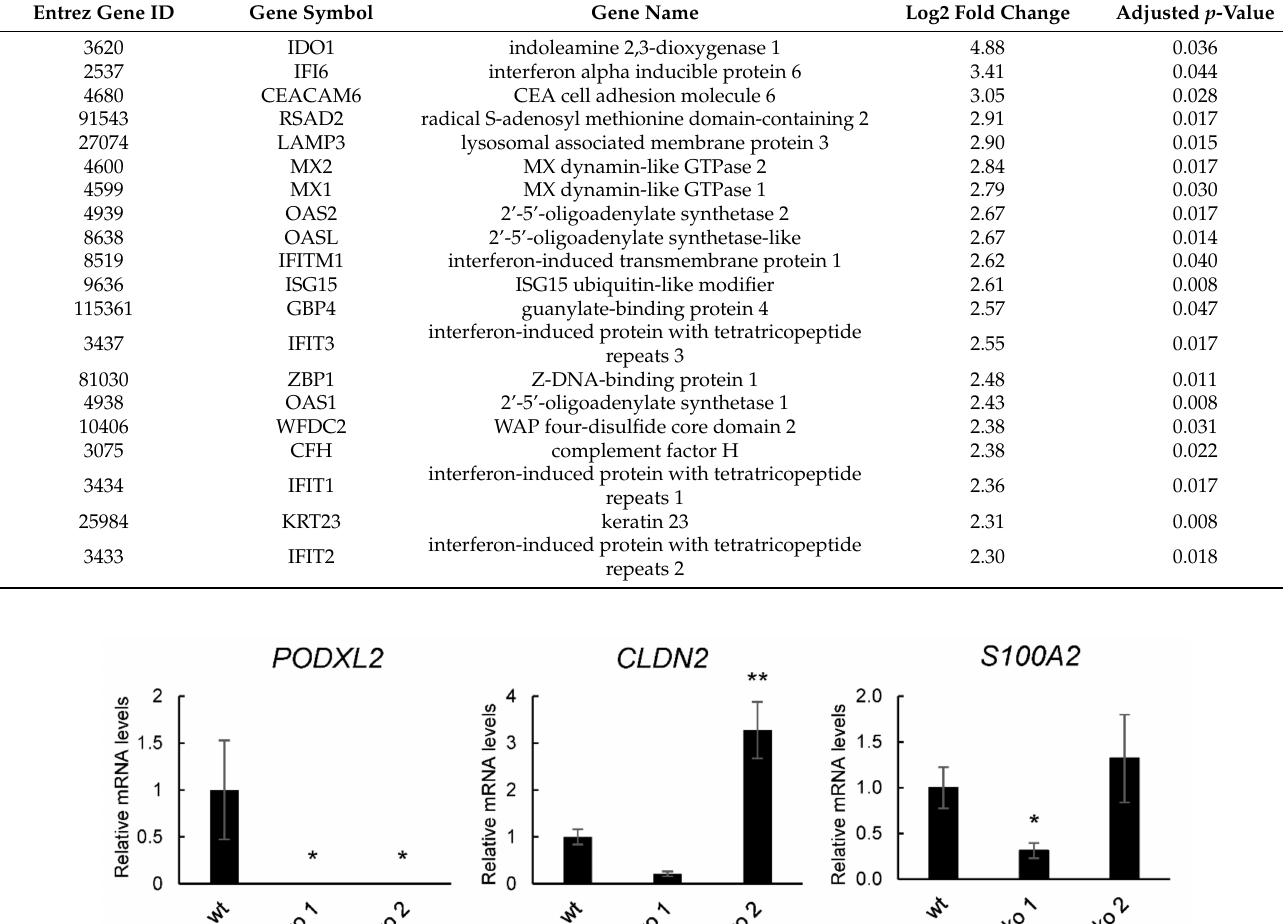
Table 3. Top 20 upregulated genes in ITGB6 -knockout cholangiocarcinoma (HuCCT1) cell line.